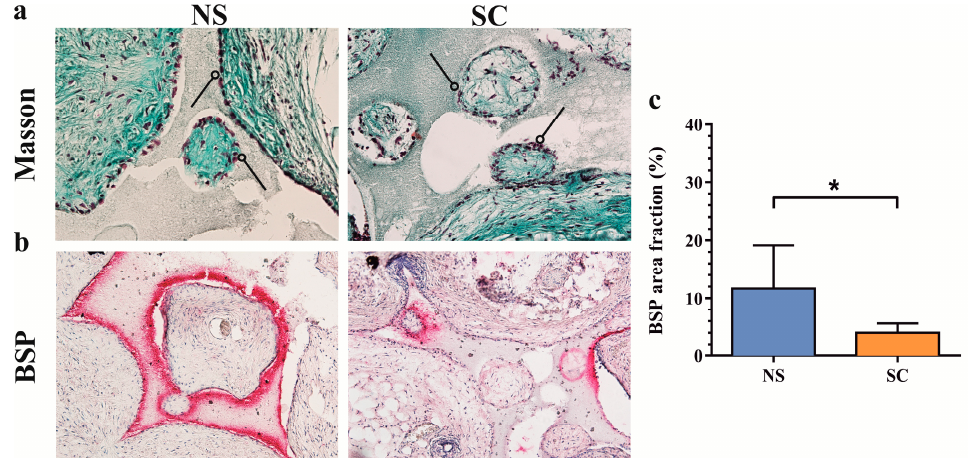
Figure 4. Histological characterization of de novo calcified tissues formed by osteoprogenitors from osteoarthritic subchondral bone. ( a ) Masson’s trichrome staining reveals osteoblasts (arrowheads, red nuclei) lining osteoid tissue (dense green stain). ( b ) Expression of bone sialoprotein (BSP, red) overlapping with osteoblast-like cells. ( c ) Quantification of the bone sialoprotein area normalized for scaffold pore volume (means + SEM, n = 3 donors, duplicate implantations). Magnification: 20×, NS: non-sclerotic, SC: sclerotic. * p < 0.05 by paired t -test.